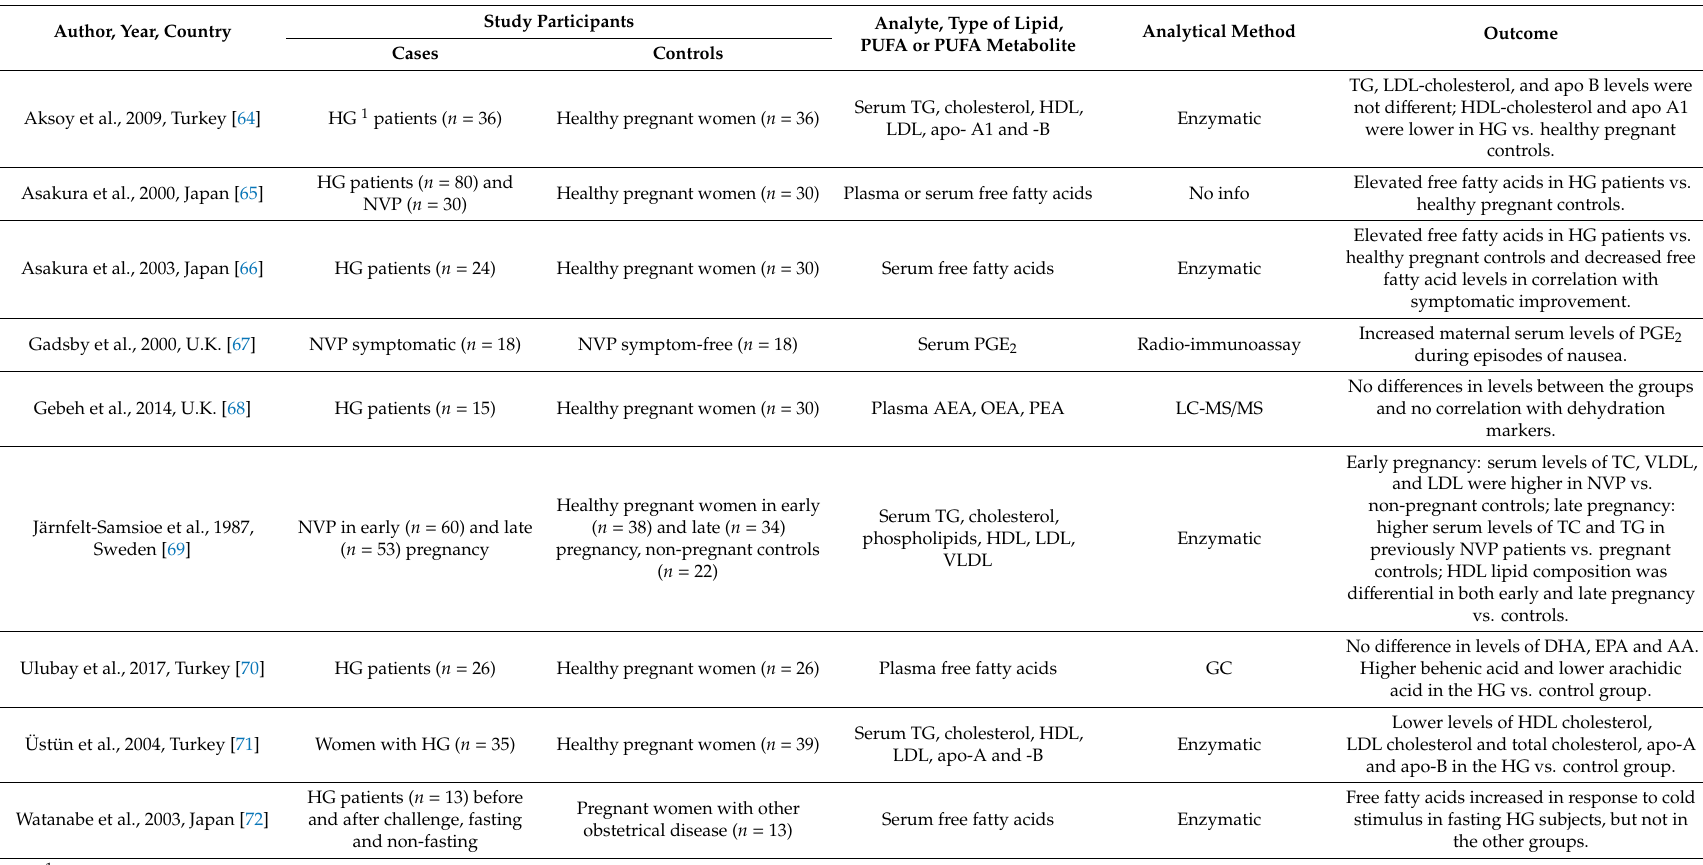
Table 1. Retrieved records from PubMed and Web of Science